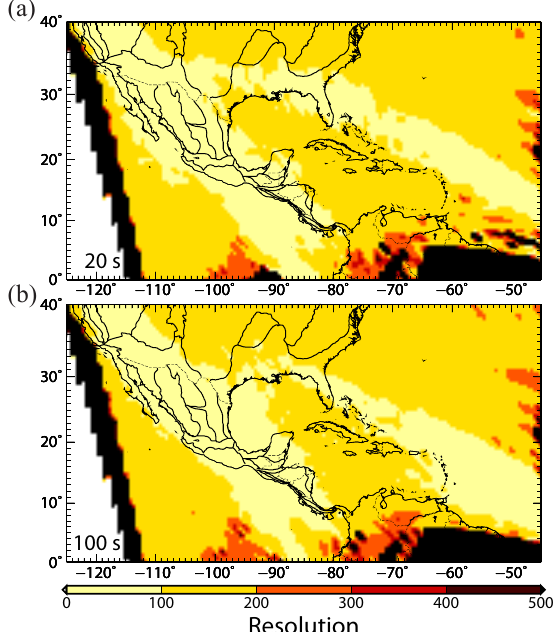
Figure 5. Examples of joining group velocity obtained from ANT (blue squares) and from earthquake tomography (empty circles) at four nodes of the inversion region representing different tectonic settings. The error bars denote resolution normalized by 2500km at each period. The gray area limits the velocity overlapping and joining period range. Filled circles and continuous red lines indicate the combined dispersion